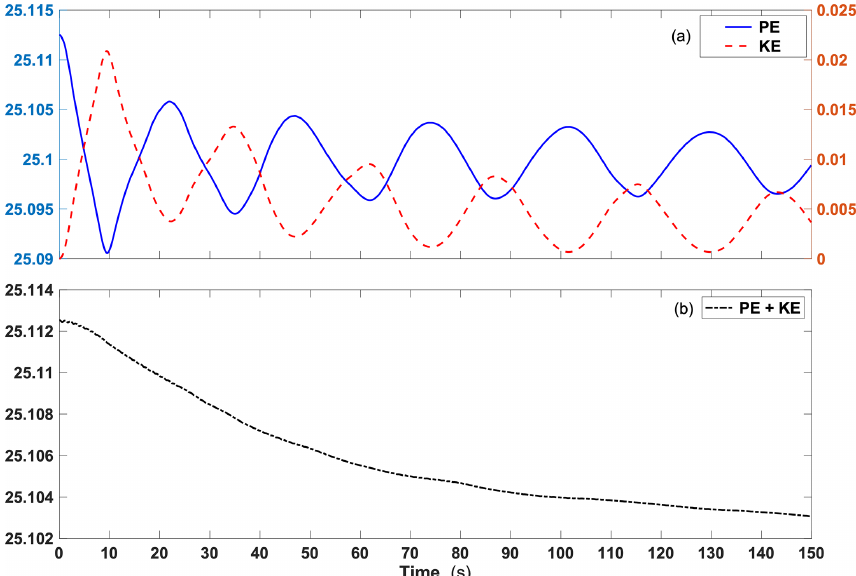
Figure 3. (a) The time series of kinematic energy (red dashed line), potential energy (blue solid line), and (b) total energy (black dotted line) (units: kgm 2 s − 2 )